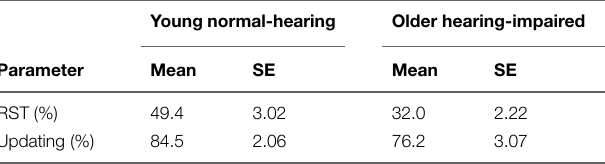
TABLE 1 | Mean and SE values for RST and updating test for each population group.